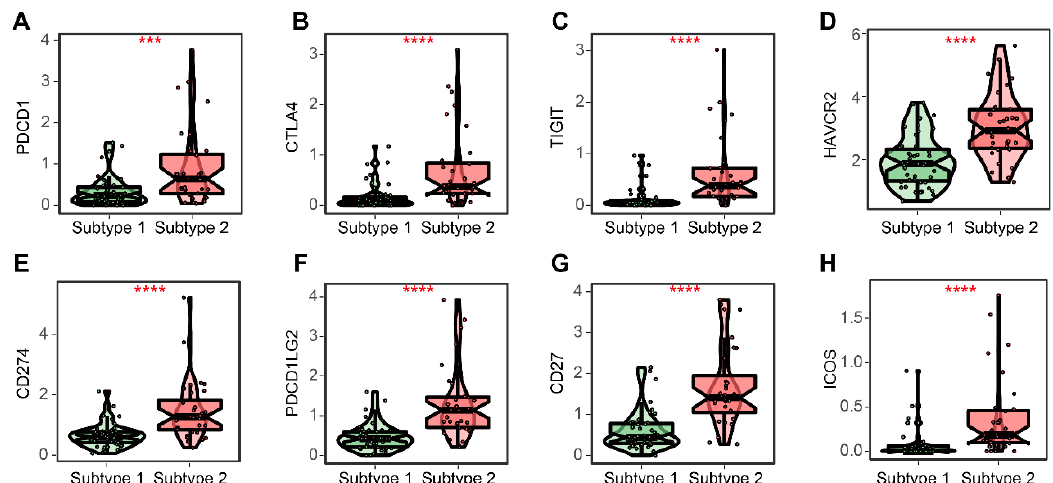
the Wilcoxon test; *** p < 0.001, **** p < 0.0001.